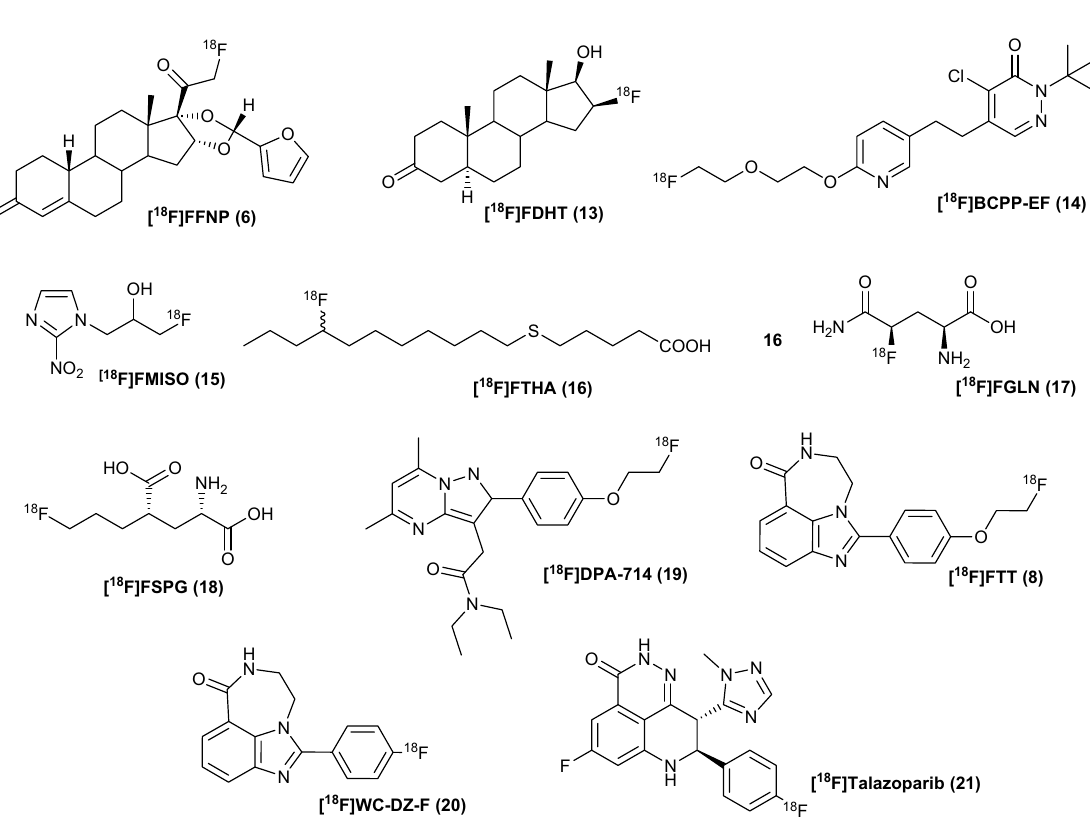
Table 1. Radiosynthesis of 18 F-labeled radiopharmaceuticals using [ 18 F]TsF as a [ 18 F]fluoride source. a. Radiochemical yield (RCY) was the isolated yield after HPLC purification (decayed corrected) starting from [ 18 F]TsF; b. Molar activity of [ 18 F]TsF; c. The radiosynthesis started from [ 18 F]fluorobenzaldehyde [RCC(Radio- TLC): 97%]; d. RCY was reported as the chiral